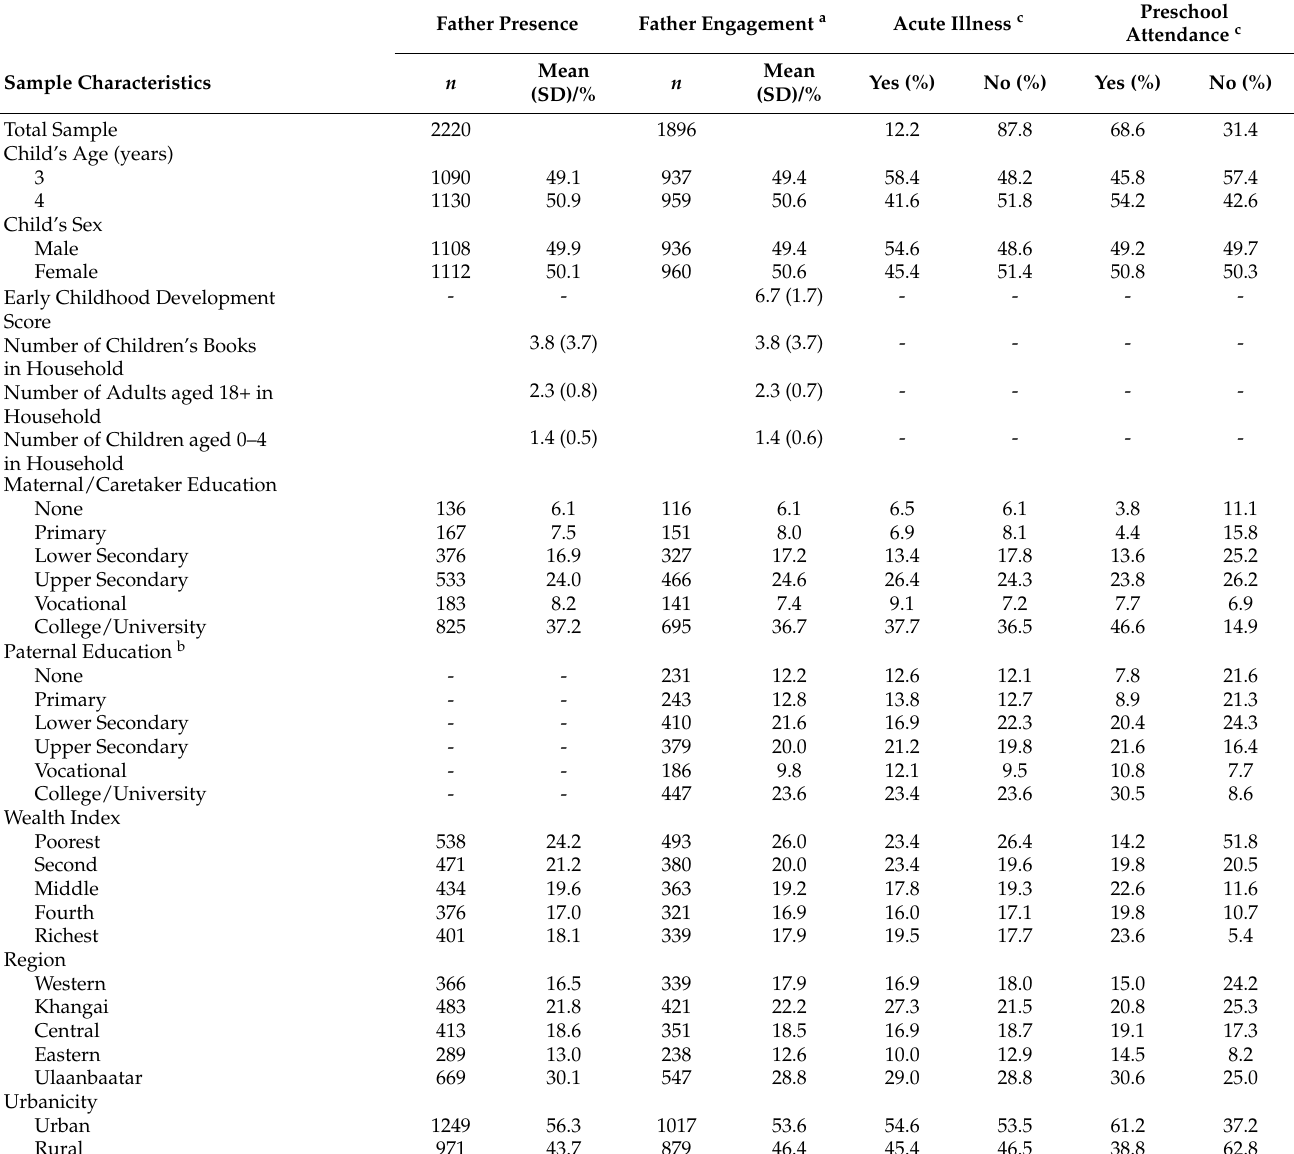
Table 1. Characteristics of the study population by primary exposure and outcome